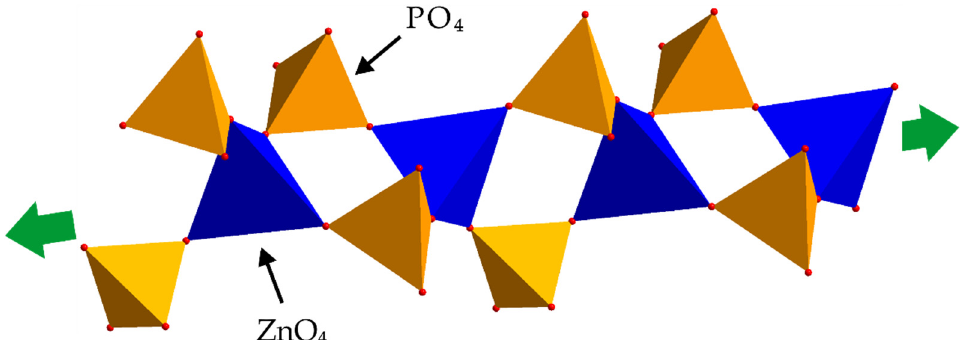
Figure 2. Model of a single polymeric chain proposed on the basis of the partially refined crystal structure of ZnDBP. Green arrows indicate the direction in which the ZnDBP chain propagates. For the clarity of presentation, carbon and hydrogen atoms are omitted, whereas red dots represent oxygen atoms.